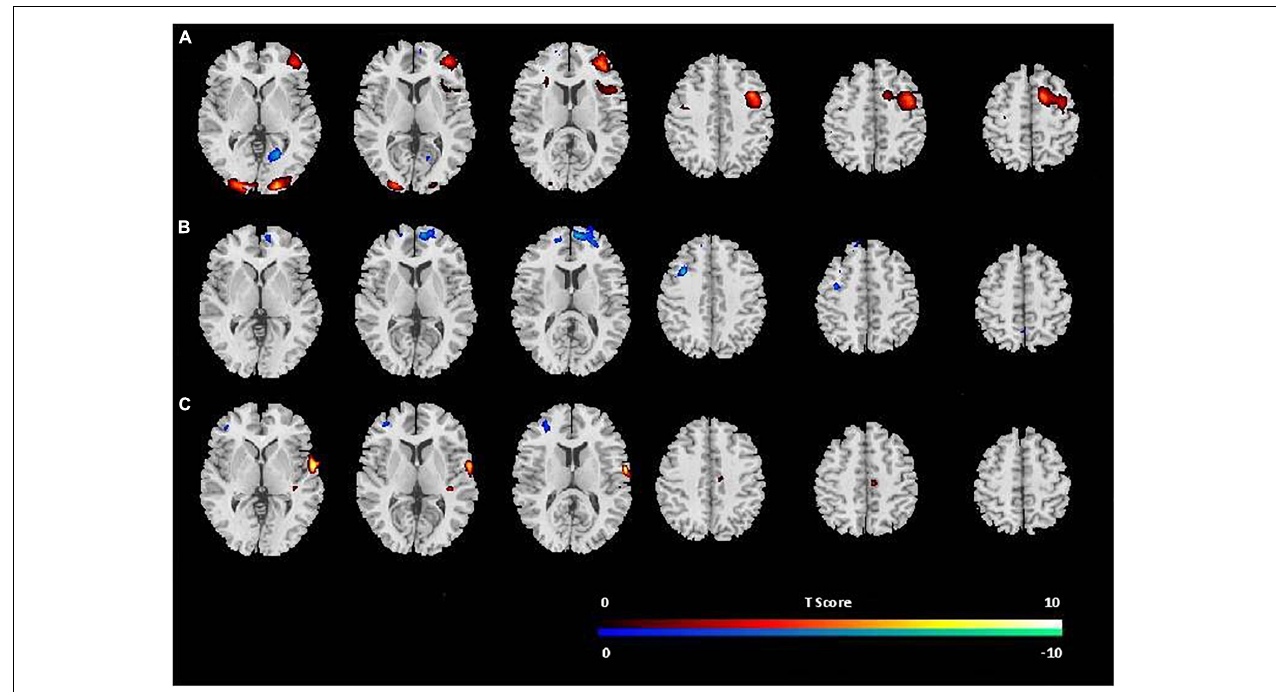
FIGURE 3 | Brain areas with increase (red) or decrease (blue) in CBF (A) during PVT performance in comparison to the resting baselines; (B) post-task resting baseline in comparison to pre-task resting baseline; (C) during fifth quintile PVT scores in comparison to first quintile PVT scores. The threshold of display was set as uncorrected p < 0.001. TABLE 1 | Brain areas showing (A) significant activation (CBF increases) and deactivation (CBF decreases) to the PVT compared to resting baselines (PVT vs. Rest) and (B) CBF decreases for post-task resting baseline compared to pre-task resting baseline (Rest 2 vs. Rest 1). Region Cluster size MNI coordinates Peak Z Peak p (uncorrected) x y